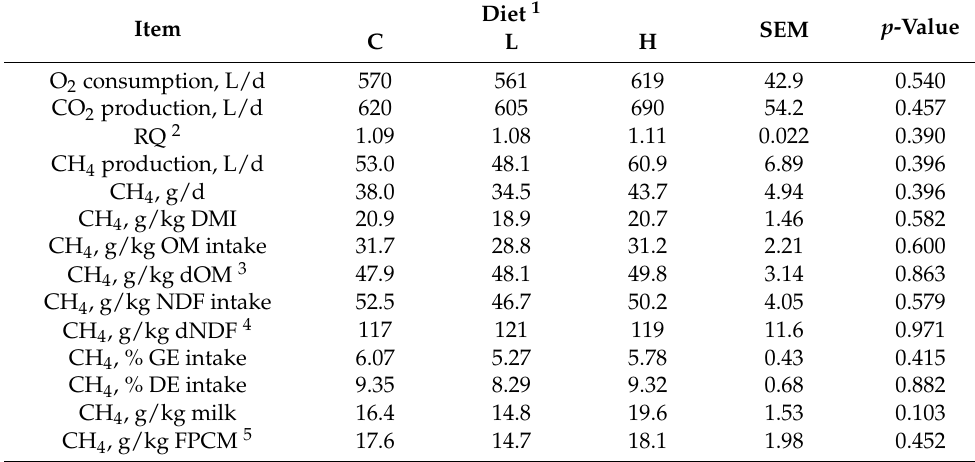
Table 7. Gas exchange and methane production of the goats fed the experimental diets.